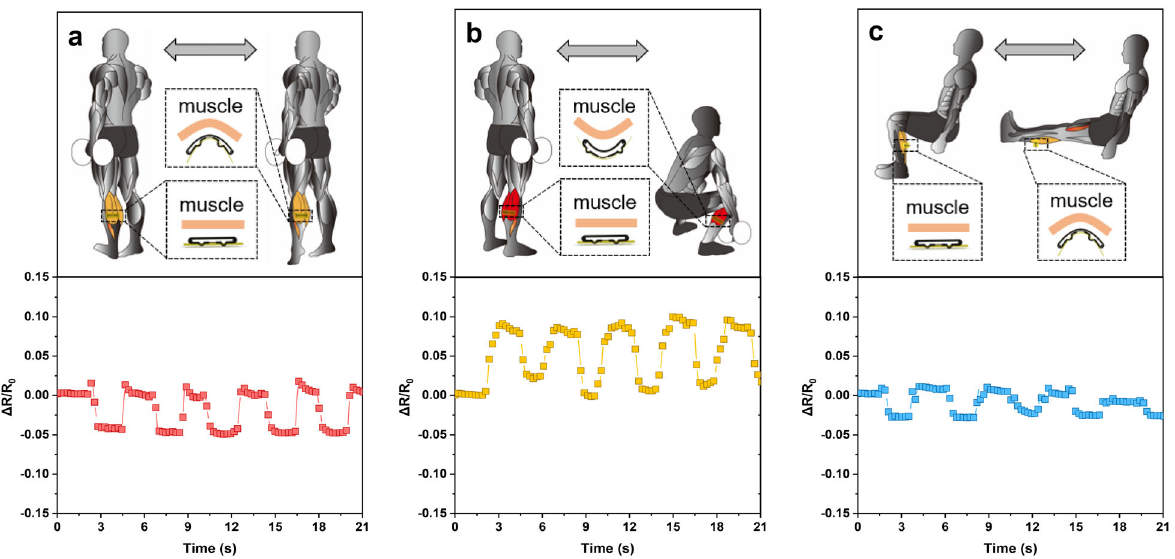
Fig. 4 Subtle motion monitoring by a single channel. H-junction bending sensor reverse horizontally attached to epidermis corresponding to the calf muscle group. Responses in resistance during the fi tness exercise of ( a ) standing heel lifts, ( b ) squat, and ( c ) leg extensions,